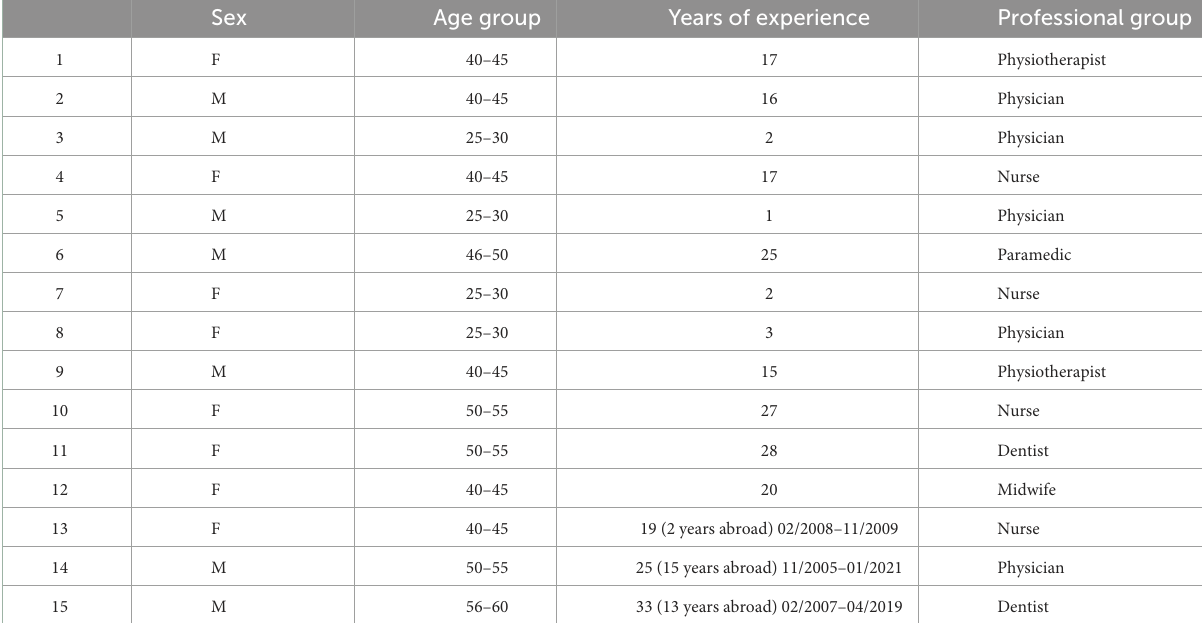
TABLE 1 Sociodemographic characteristics of the sample